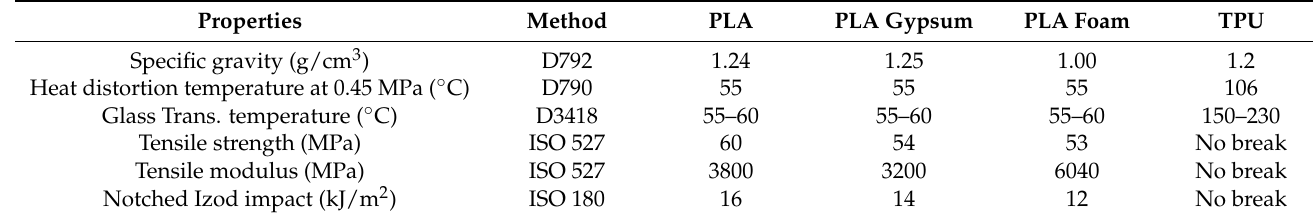
Table 1. Properties of the commercially available filaments.